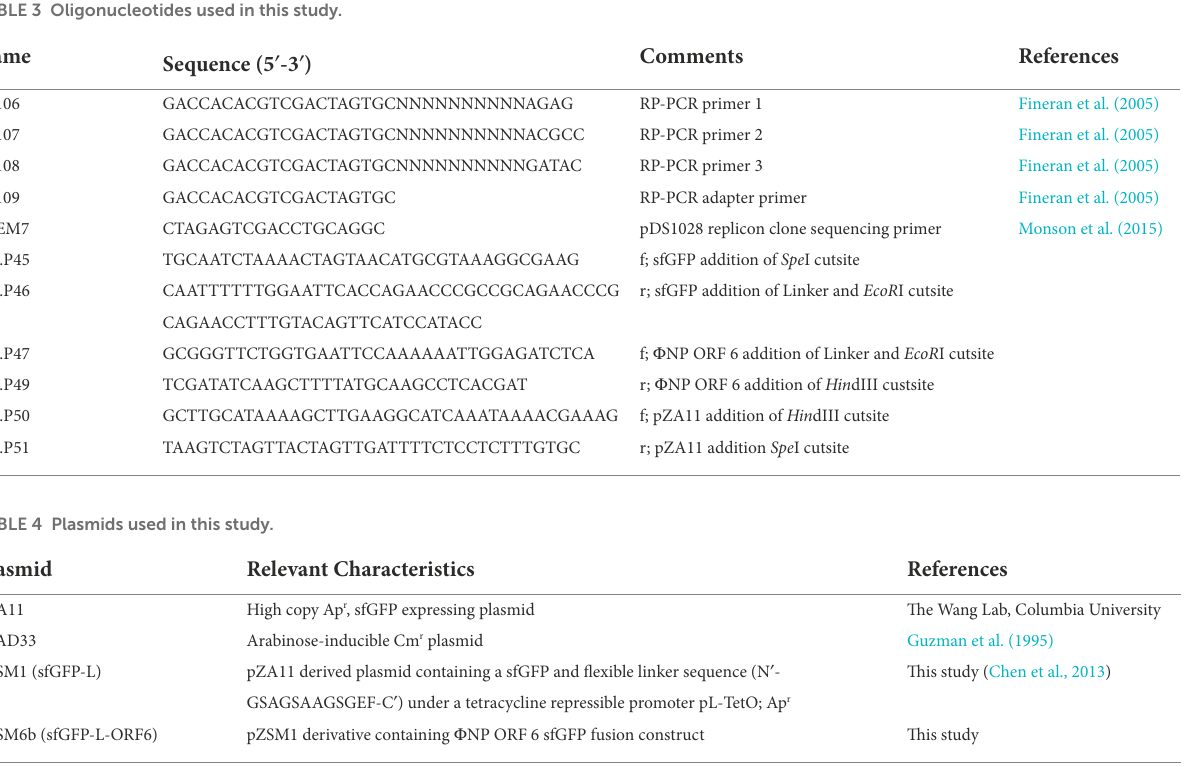
TABLE 3 Oligonucleotides used in this